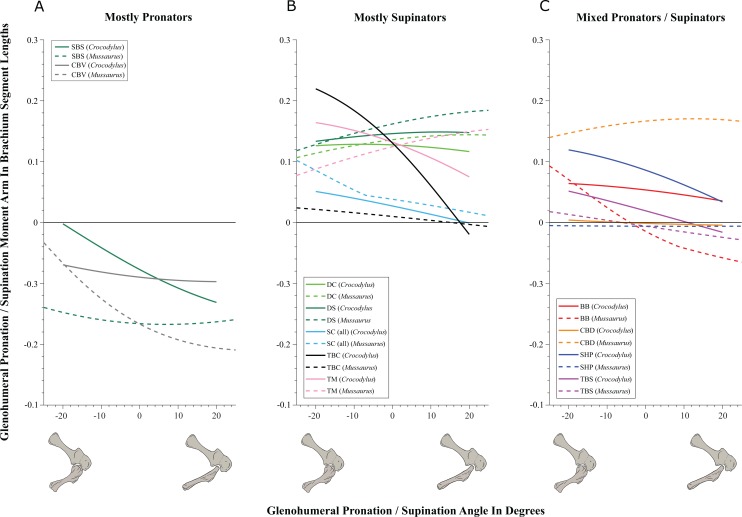
Pronation/supination moment arms around the glenohumeral joint, normalized to humerus segment length, plotted against pronation/supination joint angles for Crocodylus and Mussaurus in the resting pose.(A) Mostly pronators; (B) mostly supinators; (C) mixed pronators/supinators. Negative moment arms and glenohumeral angles correspond to pronation, while positive values correspond to supination. For muscle abbreviations, see Table 1. For a similar plot using glenohumeral extension/flexion joint angle on the x-axis, see Fig. S8.